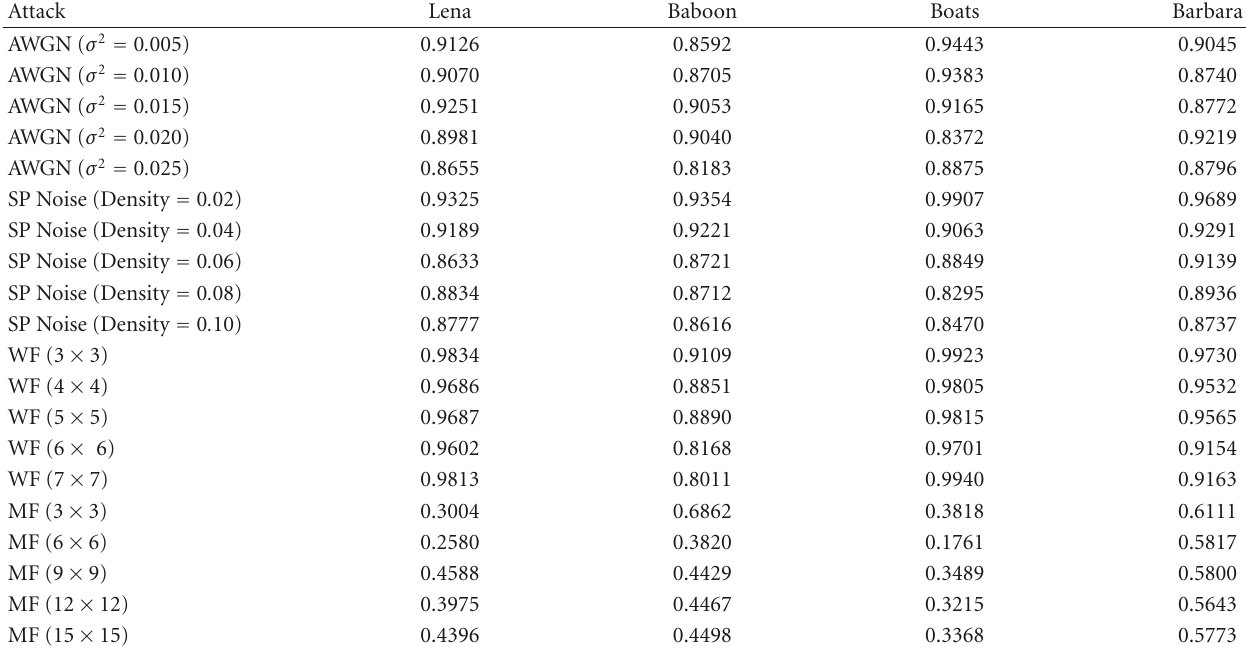
Table 2: Correlations between the original and the extracted watermarks under Noise and Filtering attacks.